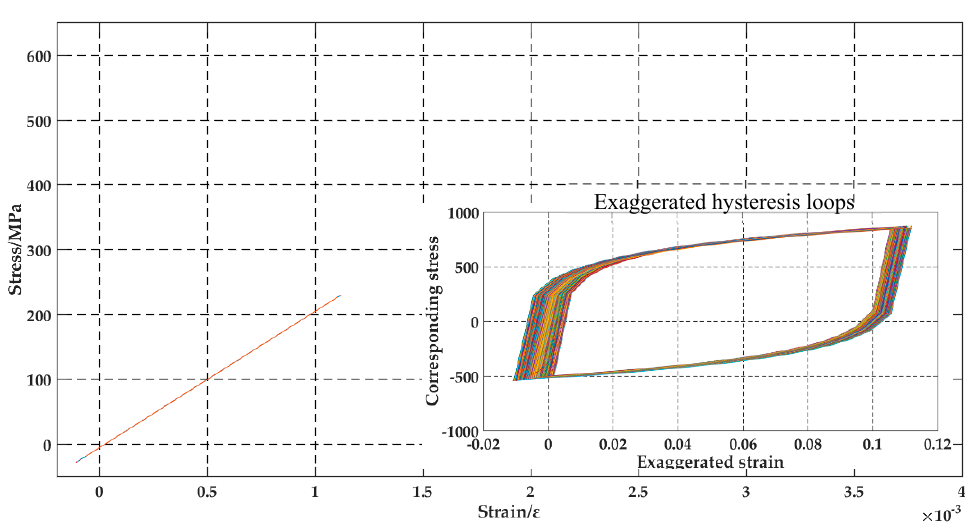
Figure 14. Strain stress response curve ("strain stationary" phase for testing point 3#).